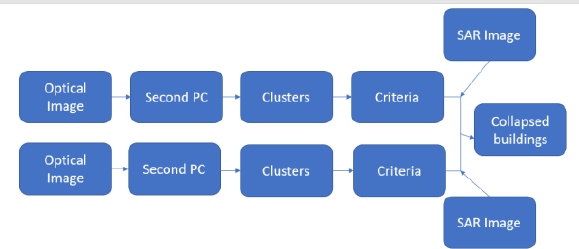
Figure 7. Method